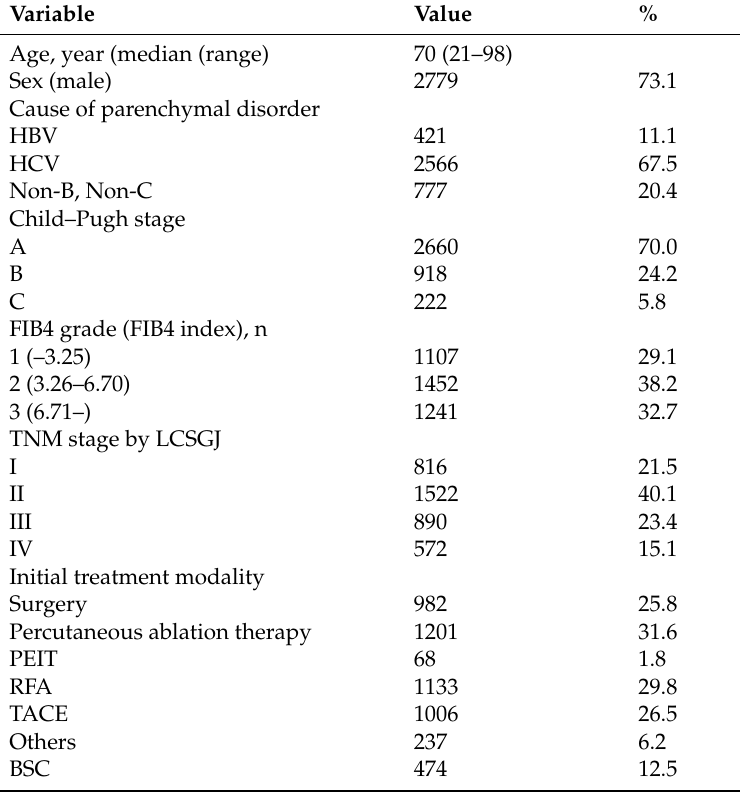
Table 2. Characteristics of the 3800 patients included in the study.